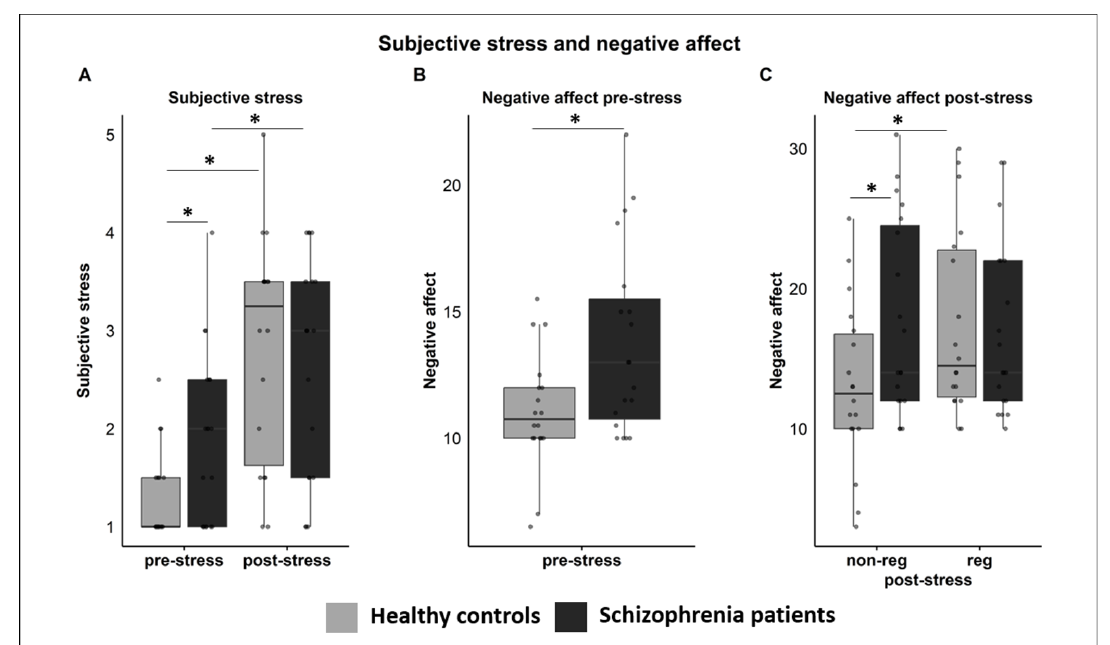
Figure 2. Illustration of significant interactions as revealed by the ANOVAs for subjective ratings. ( A ) Subjective stress, interaction “time-by-group”: SZP compared to HC had higher subjective stress before the stress paradigm. Subjective stress increased in both groups from before to after the stress paradigm. ( B , C ) are disentangling the 3-way interaction “regulation-by-time-by-group” for negative affect. ( B ) Pre-stress, group main effect: SZP compared to HC had higher negative affect before the stress paradigm. ( C ) Post-stress, interaction “regulation-by-group”: SZP had higher negative affect than HC after the non-regulation block. HC reported higher negative affect after the regulation compared to the non-regulation block. No significant group difference appeared after the regulation block. non-reg = non-regulation block; reg = regulation block. Significant differences are marked with *.